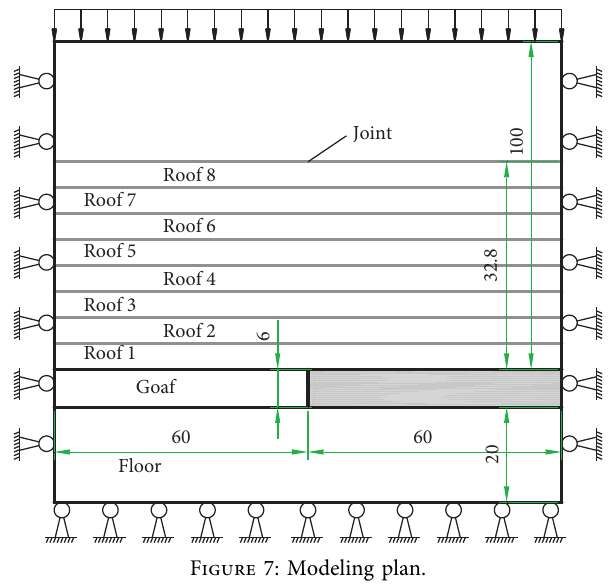
Figure 7: Modeling plan.